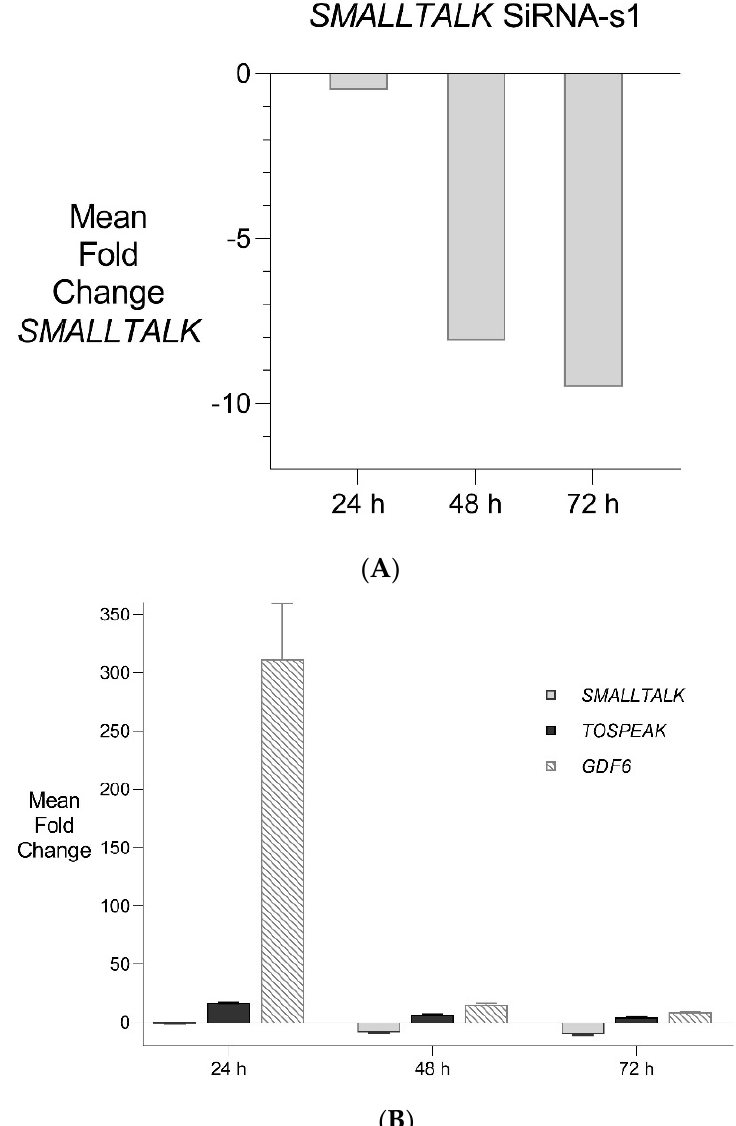
Figure 5. Transient Transcriptional Interference. ( A ) siRNA mediated knockdown of SMALLTALK : Comparative rtPCR expression analysis of SMALLTALK in the normal human fibroblast cell line (NC1) over 72 h following exposure to siRNA-S1 targeting SMALLTALK, expressed as the mean fold change relative to the mean for untreated control levels. ( B ) siRNA mediated transient transcriptional interference of SMALLTALK : Comparative rtPCR expression analysis of SMALLTALK, TOSPEAK and GDF6 in the normal human fibroblast cell line (NC1) over 72 h following exposure to siRNA-S1 targeting SMALLTALK expressed as the mean fold change relative to untreated control levels.